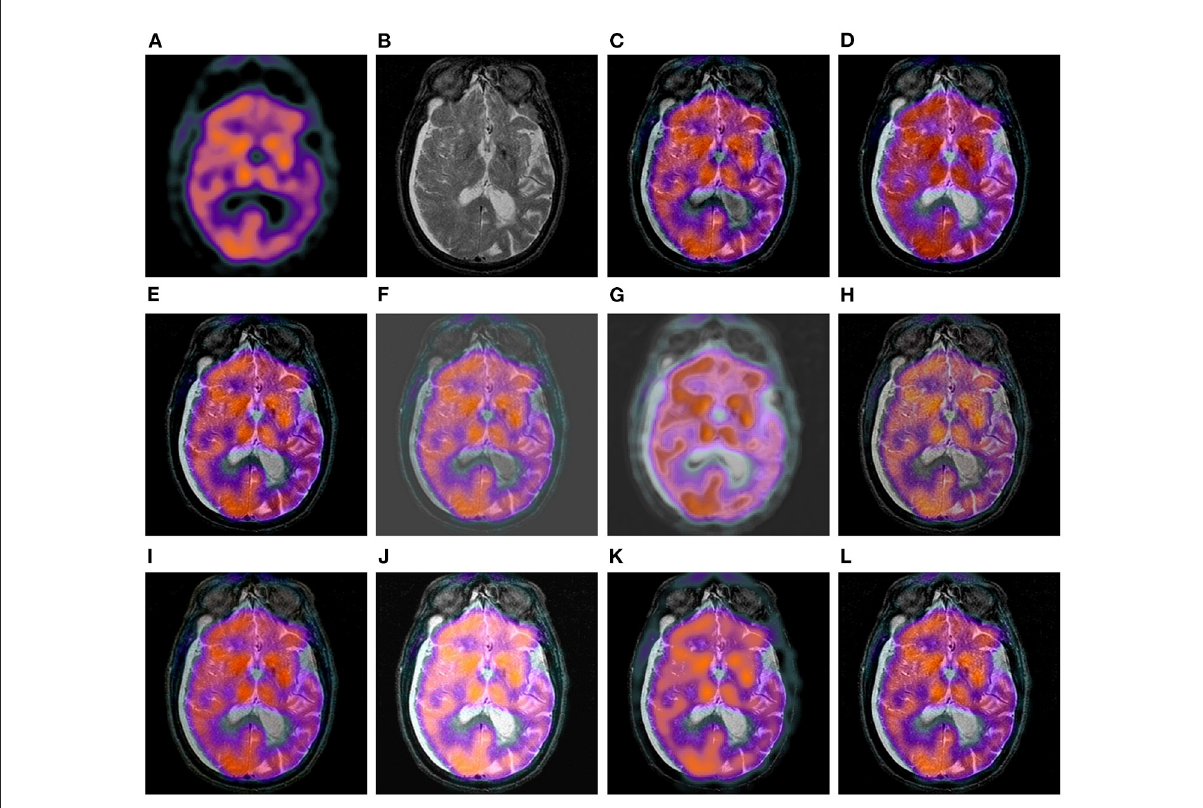
FIGURE8 Comparison example on the SPECT-MR image dataset. (A,B) are the original SPECT image and MR image, respectively. (C–L) are the fusion results of DWT, GFF, LPSR, U2Fusion, DDcGAN, IFCNN, EMFusion, DRBIF, LEGFF 0 , and our method,